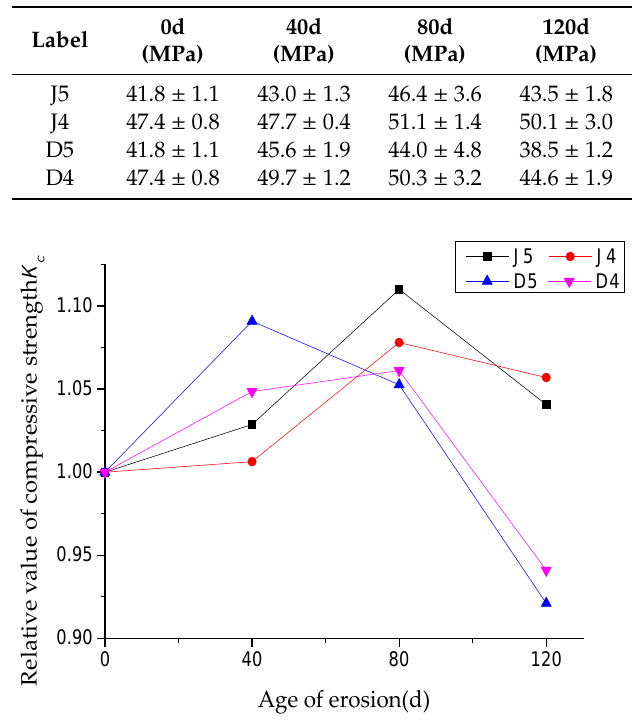
Figure 2. The relationship between the relative compressive strength and erosion age.